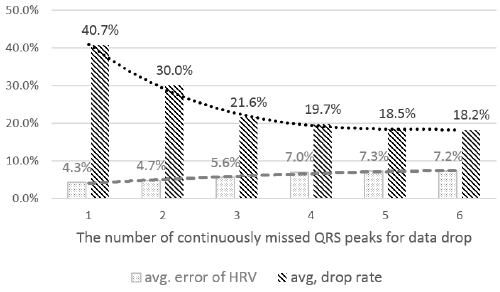
Figure 4. The average error of the HRV parameters and the average drop rate by the number of consecutively-missed QRS peaks.